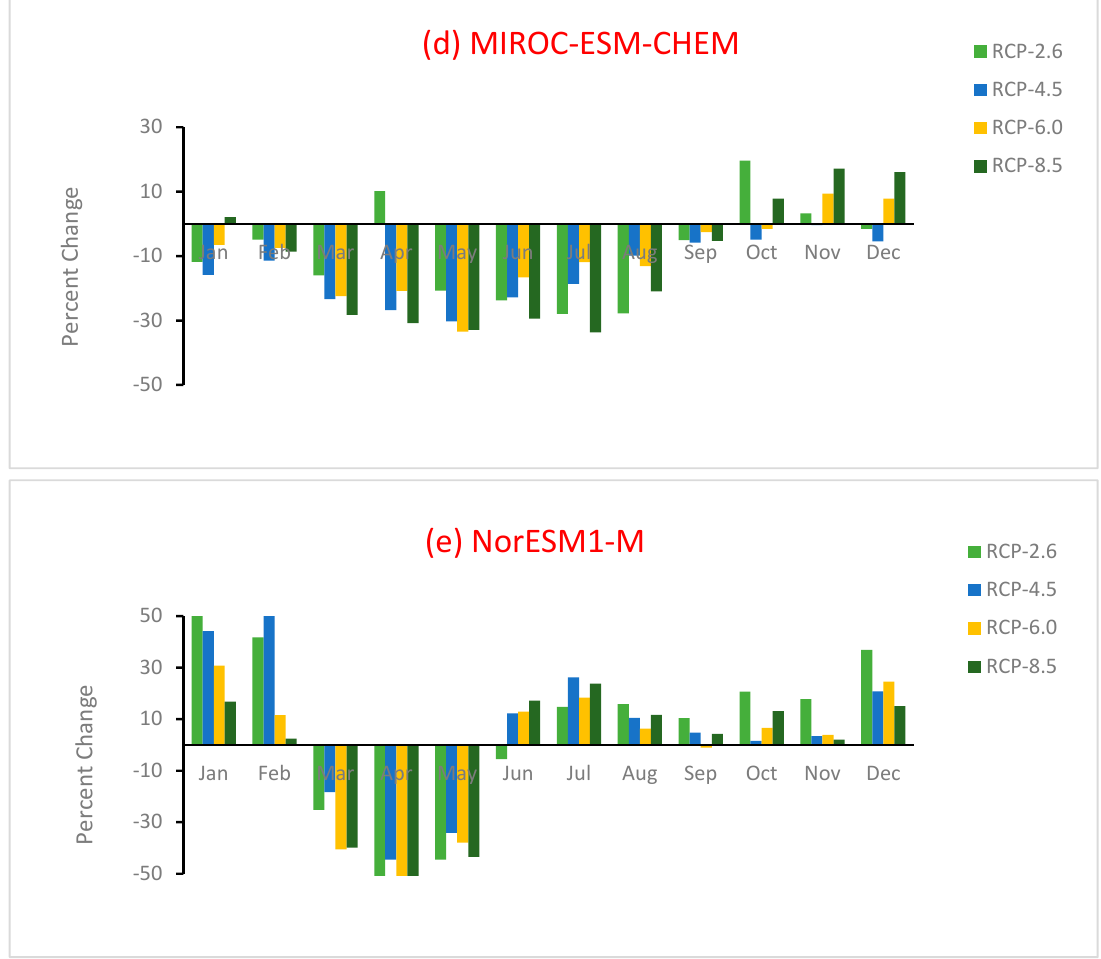
Figure 7. Percent change of mean monthly discharge for the future period under four emission scenarios for each global climate model: ( a ) GFDL-ESM2M, ( b ) HadGEM2-ES, ( c ) IPSL-CM5A-LR, ( d ) MIROC-ESM-CHEM, and ( e ) NorESM1-M.